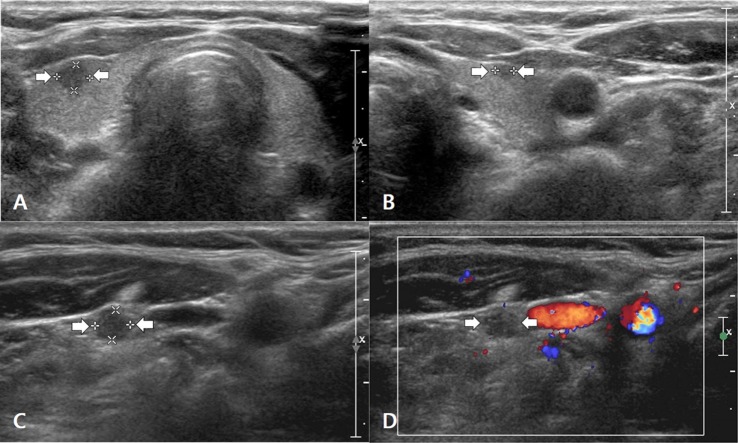
A 55- to 60-year-old woman with nodal tumor recurrence/persistence of papillary thyroid carcinoma (PTC). Before thyroid surgery, transverse gray-scale sonograms showed a primary PTC in the right lobe (A) (arrows, 3.6 mm × 4.5 mm × 4.7 mm) and a secondary PTC in the left lobe (B) (arrows, 2.0 mm × 2.4 mm × 2.7 mm). However, no suspicious lymph node was found on preoperative ultrasonography (US). On histopathologic examination after total thyroidectomy and central neck dissection, bilateral PTCs in both lobes and a single nodal metastasis in the right central neck were confirmed. On the 35-month follow-up US examination after total thyroidectomy, a transverse gray-scale sonogram (C) showed a suspicious lymph node with a round shape and diffusely increased echogenicity in the right mid-neck (arrows, 3.6 mm × 4.3 mm × 4.5 mm). On the transverse color Doppler sonogram (D), the suspicious lymph node showed scant vascularity. After US-guided fine-needle aspiration for this node, nodal metastasis of PTC was diagnosed on cytology. After consecutive nodal dissection in the right neck, several metastatic nodes were confirmed on histopathologic analysis, and the patient underwent radioactive iodine ablation for the first time. There was no suspicion of tumor recurrence/persistence on subsequent follow-up US examinations (at intervals of 44, 56, 69, 82, 94, and 107 months).